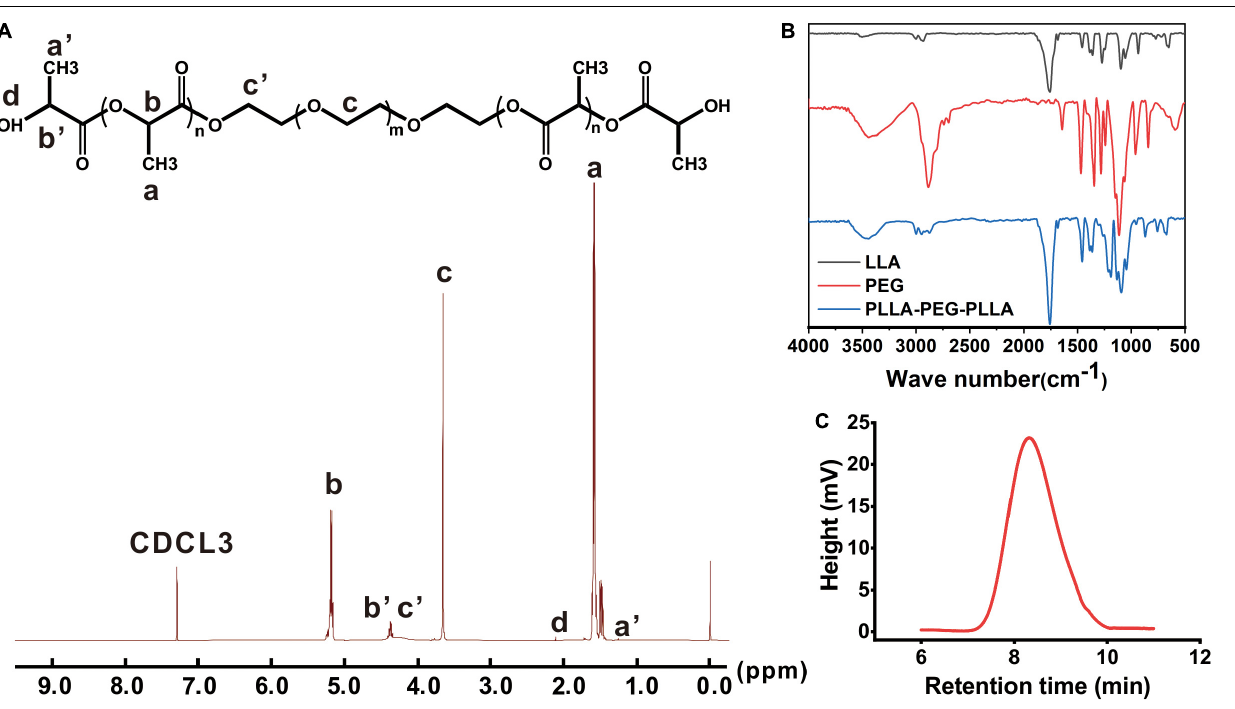
FIGURE 2 | The characterization of PLEL. (A) 1 H-NMR spectrum. (B) FTIR spectroscopy. (C) Molecular weight distribution.